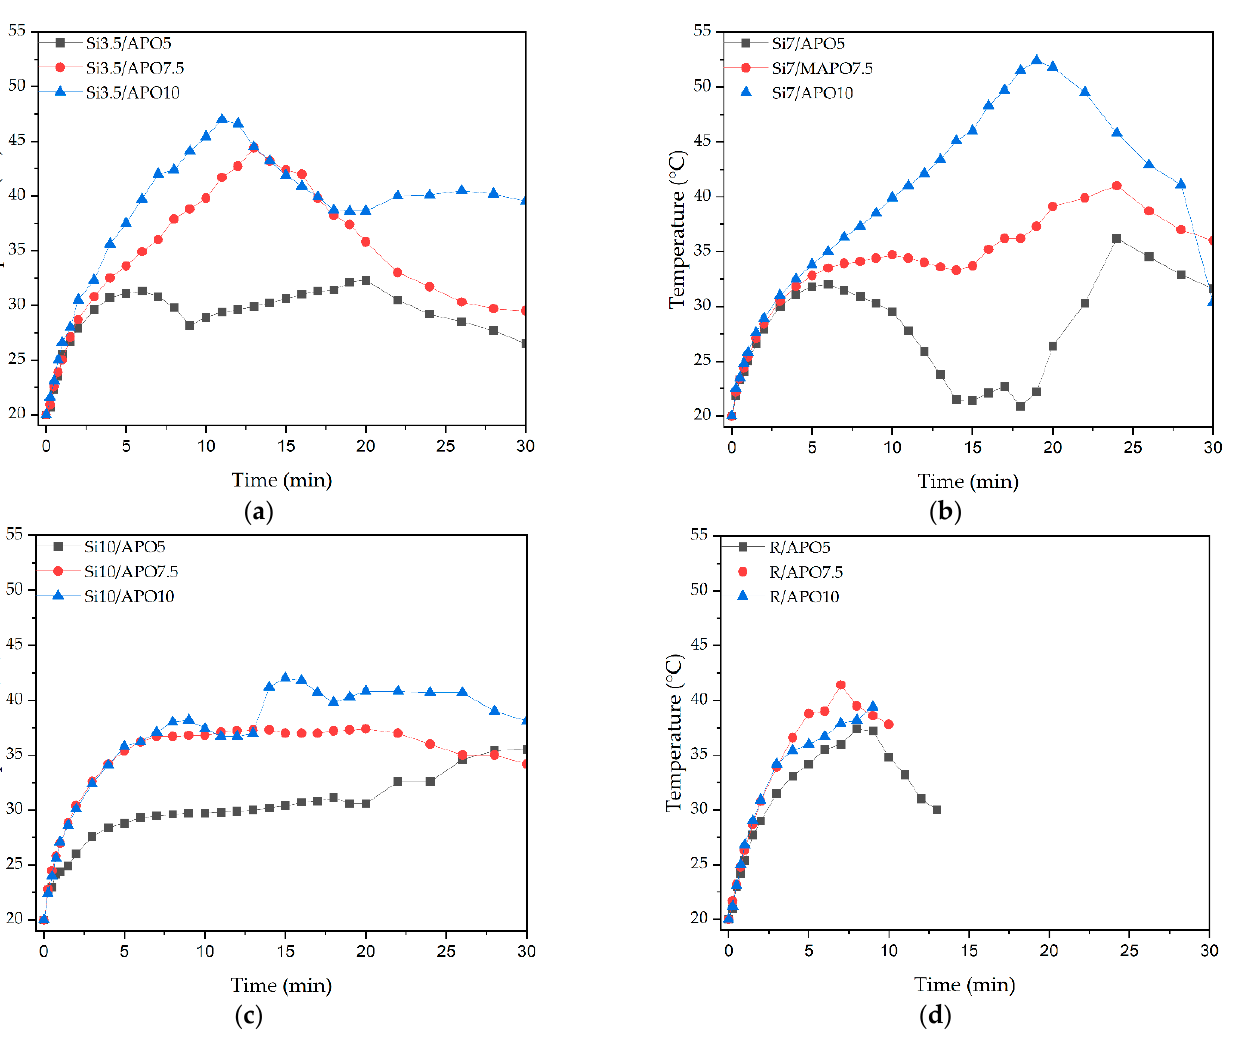
Figure 4. The temperature change in the reactor during the UV-telomerization process for 3.5 ( a ), 7 ( b ), or 10 ( c ) wt. parts TES and during the photopolymerization process ( d ).